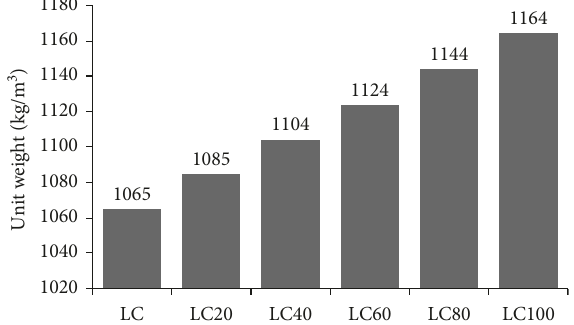
Figure 4: Effect of SWM dosage on the unit weight of